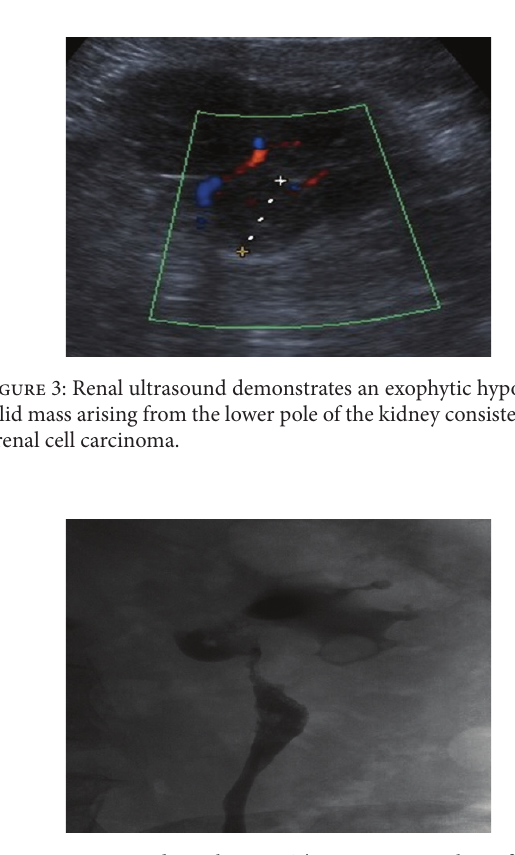
Figure 4: Retrograde pyelogram. There is an irregular infiltrative mass involving the renal pelvis and proximal ureter. This was a histologically proven urothelial cell